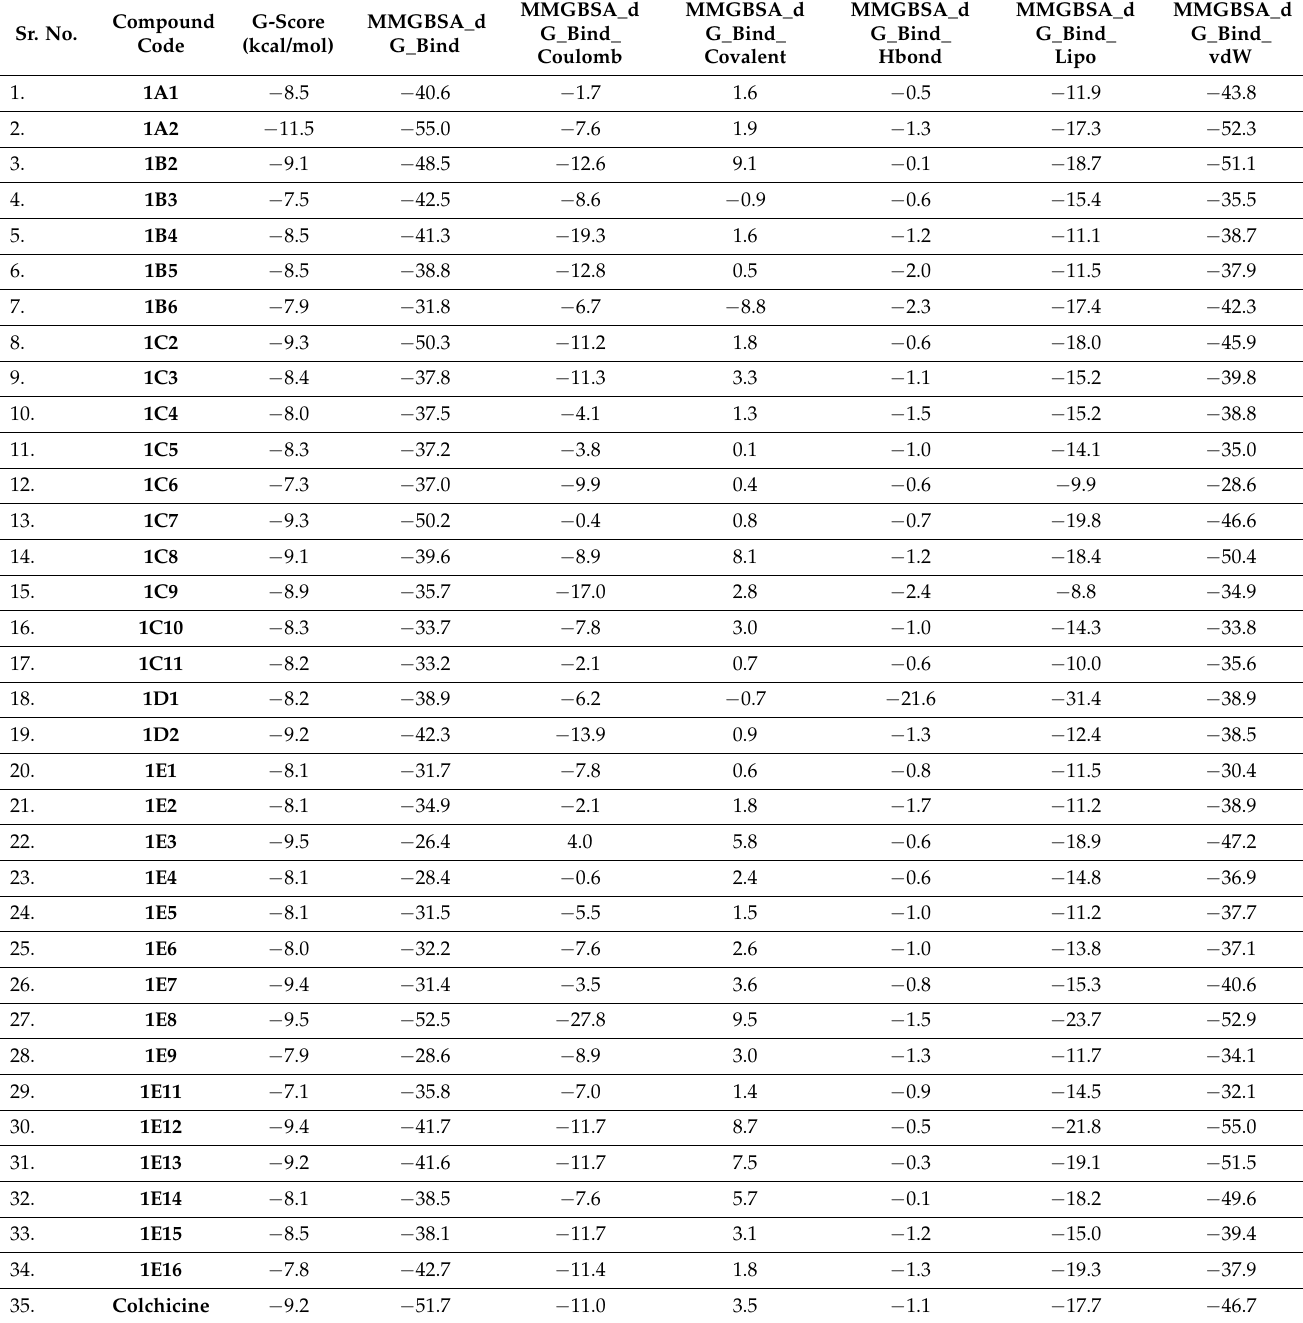
Table 1. Compilation of binding affinity scores (glide scores) and parameters of molecular